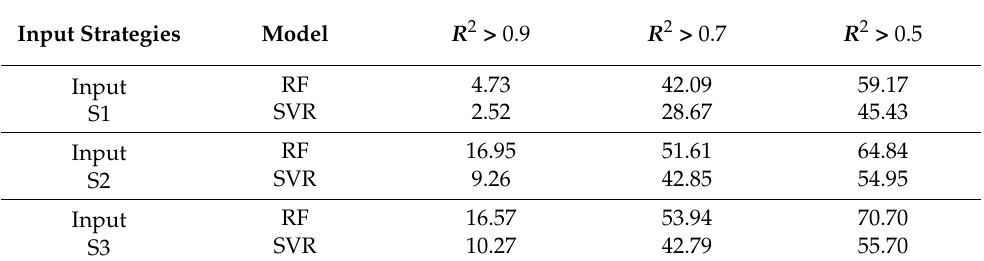
Table 6. The proportion of the grids that the R 2 exceeds the following value in the whole of South American